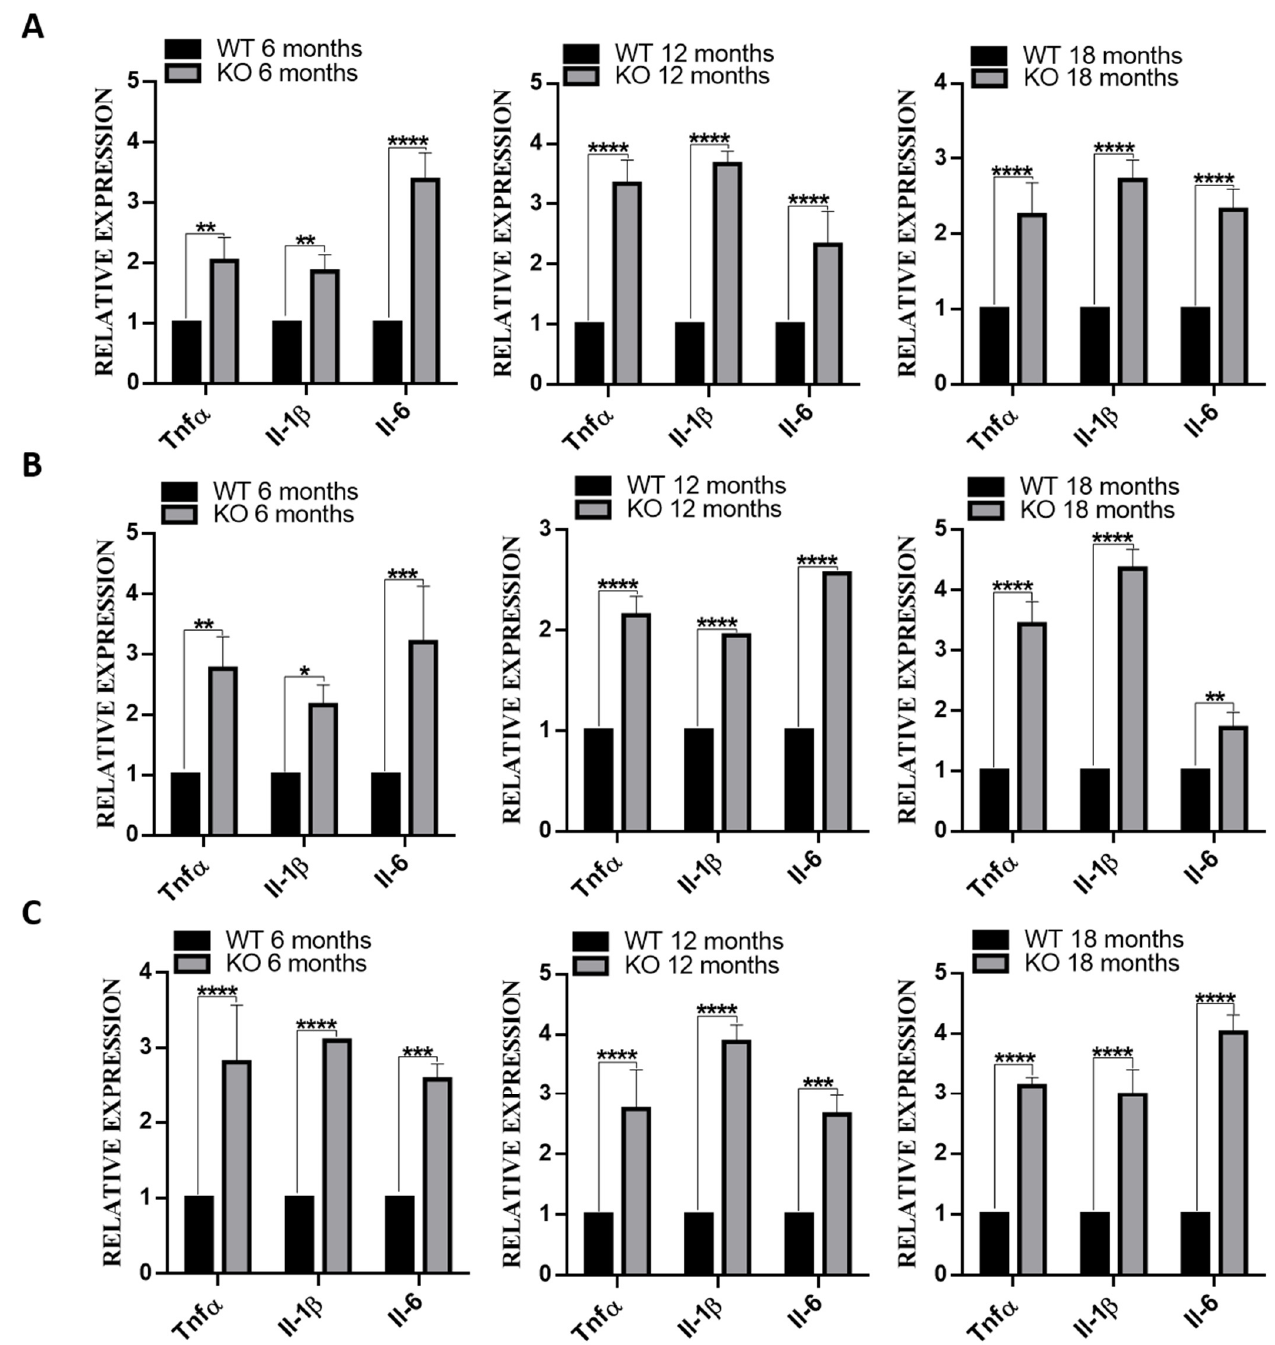
Figure 5. The expression of inflammation genes, Tnfa , Il-1 β and Il-6 , in RPE/choroid/sclera ( A ), retina ( B ) and brain ( C ) of WT and Tspo KO mice at the ages of 6, 12 and 18 months. The qRT-PCR data were collected as ct (cycle threshold) values and normalised to Gapdh , then analyzed by 2 − ∆∆ CT formula. The fold changes of each gene were presented as means ± SD and analyzed by two-way ANOVA with the appropriate post hoc test Bonferroni multiple comparisons tests ( n = 5). * p < 0.05, ** p < 0.01, *** p < 0.001, **** p < 0.0001.